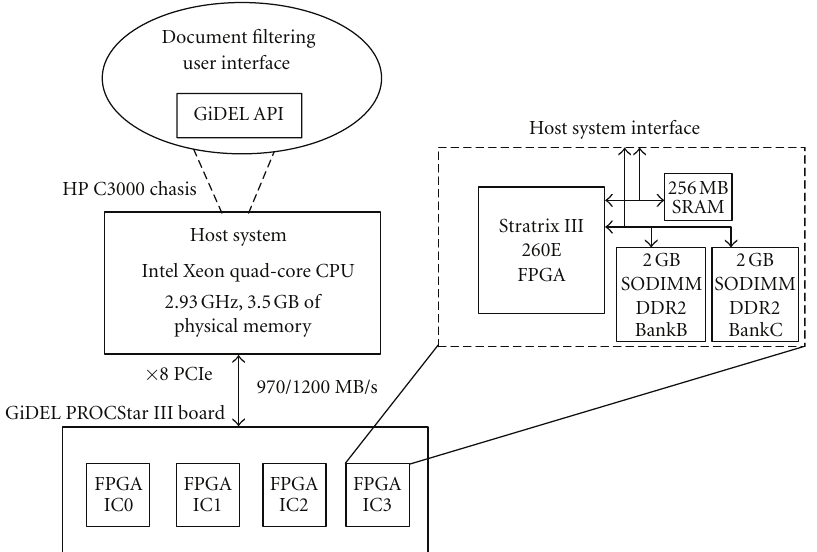
Figure 11: Block diagram of FPGA platform and photograph of experimental